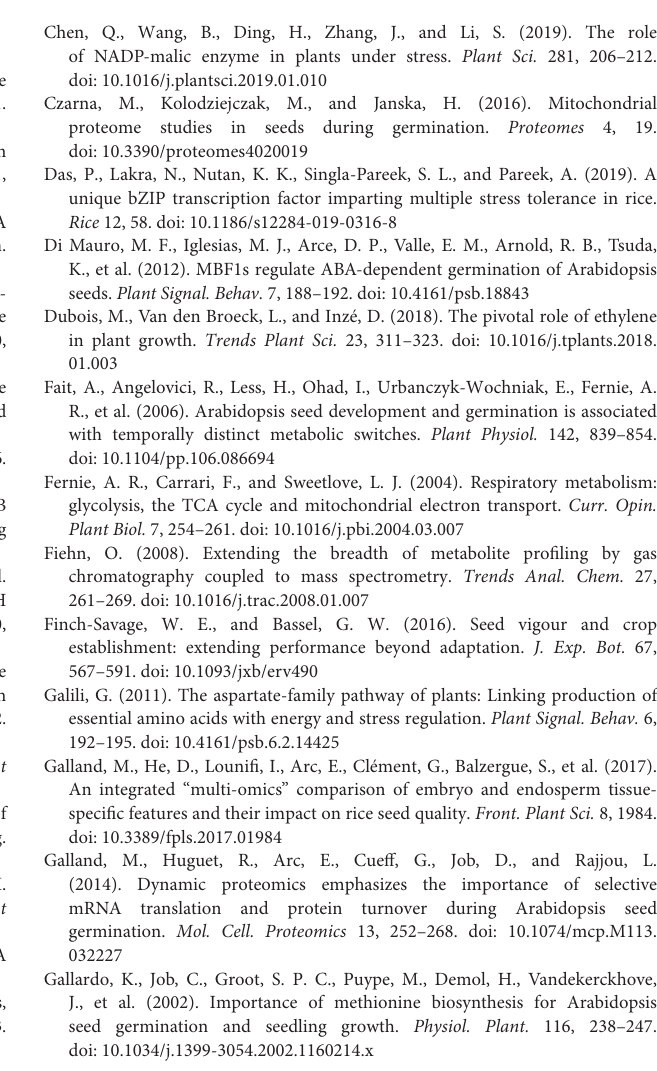
Supplementary Table S5E | The 11 significantly up-accumulated proteins in germinated rice endosperm. Selection criteria: p < 0.05, log 2 ratio_A24vsA0 > 0. MSU7_id: rice locus according to the RGAP 7.0 annotation, Ontological class: obtained by a classification from agriGO analysis tool, t_test: Student’s t -test for each protein indicating significant different mean with p < 0.05, log Supplementary Table S5F | The 11 transcripts corresponding to 11 up-accumulated proteins in rice endosperm during germination. According to the MAS5 algorithm, we detected 24,695 Affymetrix probes called “present” in at least one imbibition time and in at least two replicates (out of three) during endosperm germination. Affymetrix control probes and locus non-specific probe sets were removed from the analysis yielding a final number of 22,052 “present” probes corresponding to 16,657 unique rice loci. Then, the GCRMA normalized abundance of the endosperm germination CEL files was retrieved for these 20,052 probes. mRNA GCRMA abundance was normalized for each probe intensity by its maximum intensity over germination to get a value between 0 and 1. MSU_id: locus number according to the RGAP 7th annotation, A X : GCRMA normalized probe intensity across the germination time course with X standing for hours after imbibition (e.g., A 24 stands for 24 HAI).